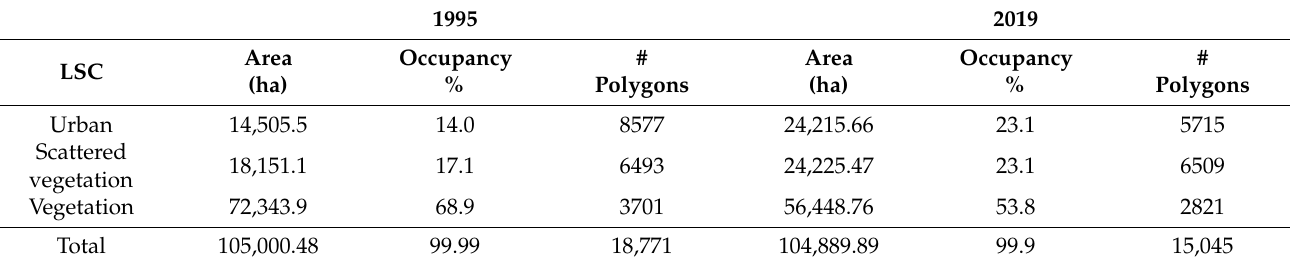
Table 3. Changes in surface of the city and class cover.